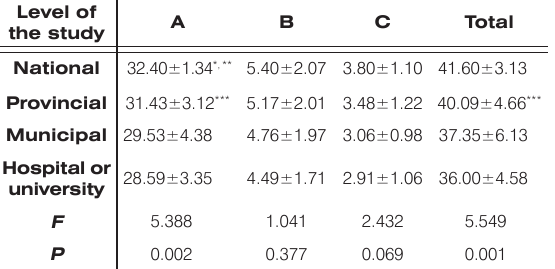
Table 3. Comparison of the evaluation scores of the clinical nursing studies at different levels Note: A: Level of the study; B: Value of the result; C: Effectiveness of the result. *: Comparison of the evaluation scores for studies at the national and municipal levels, P < 0.05; **: Comparison of the evaluation scores for studies at the national and hospital levels, P < 0.05; ***: Comparison of the evaluation scores for studies at the provincial and hospital levels, P < 0.05.